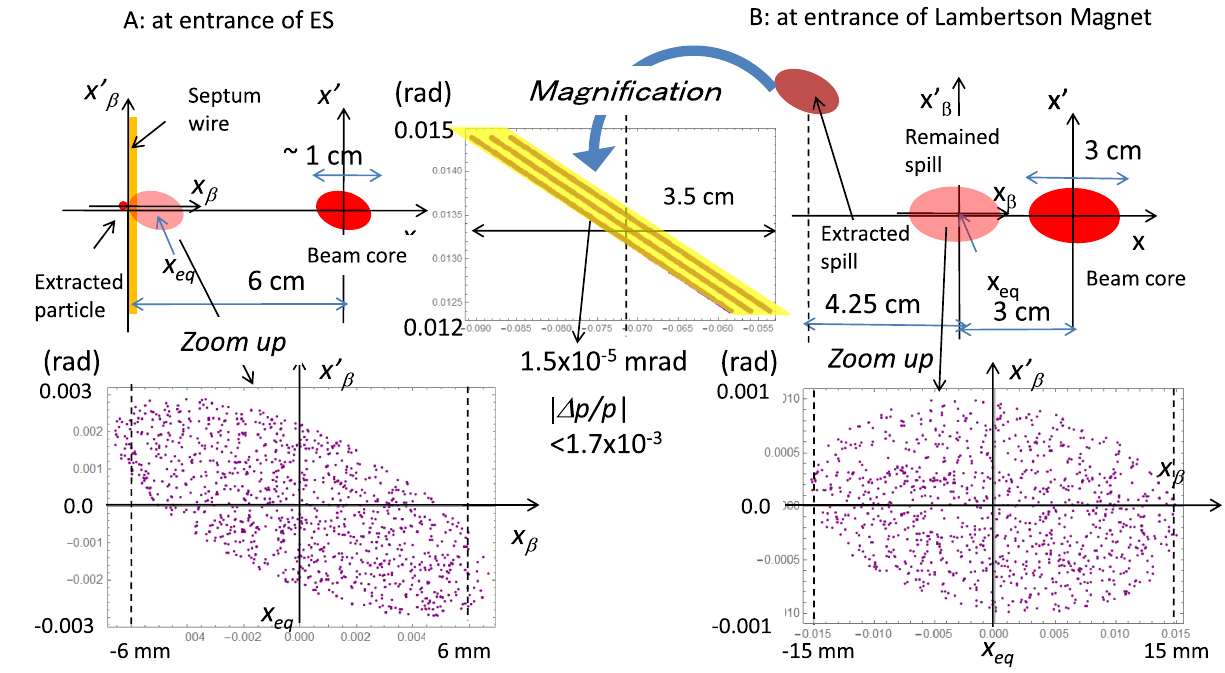
FIG. 20. Schematic phase plots of the circulating beam core, remaining spill, and spilled beam at the septum region and Lambertson magnet entrances, with tracking simulation results.